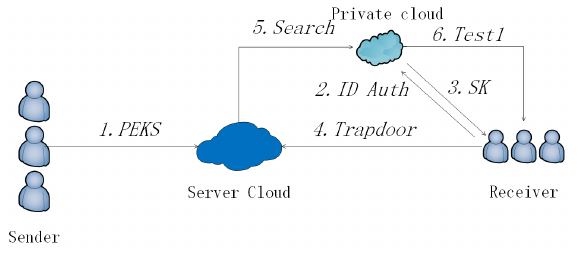
Figure 8. Multi-user ranked PEKS (MU-R-PEKS).